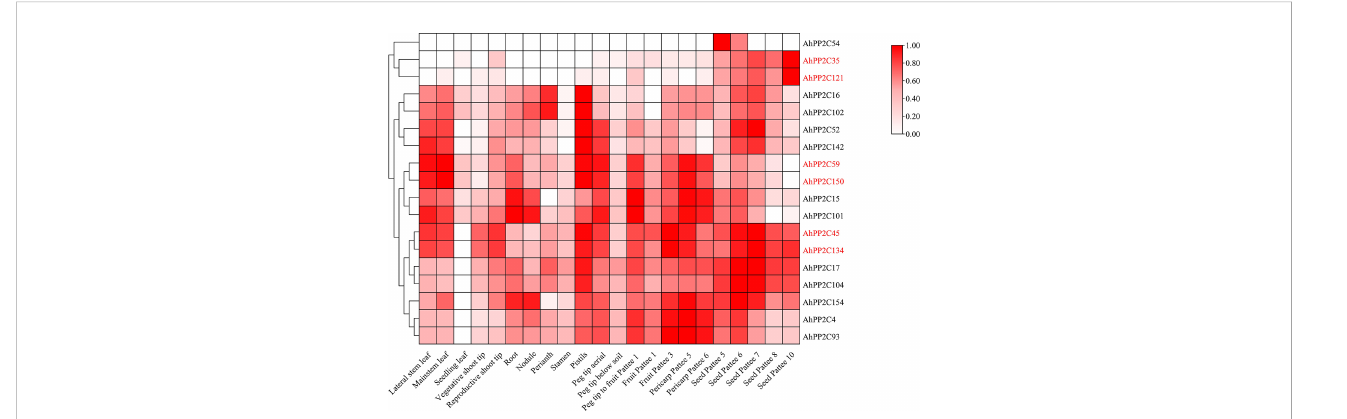
FIGURE 8 Expression pattern analysis of clade A AhPP2Cs . The heat map of log2-transformed averaged FPKM data was mapped using the intensity scale shown on the right. The visualization and clustering utilized TBtools. The AhPP2Cs of subclades AI and AII are labelled in